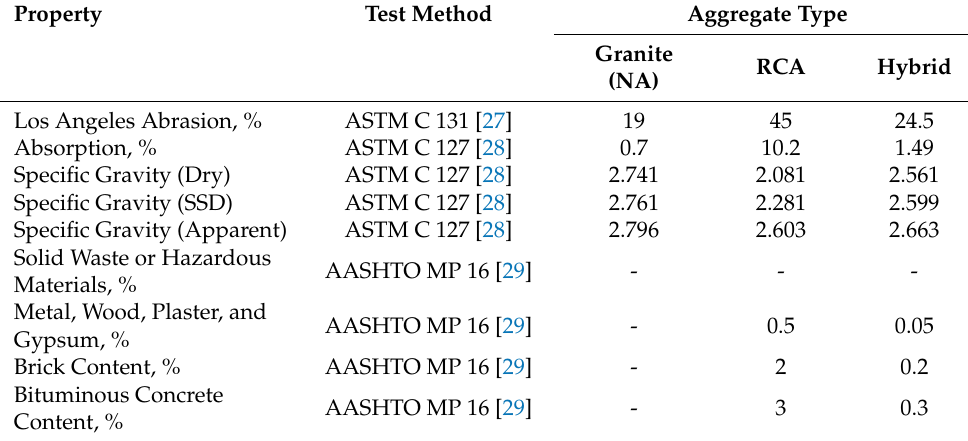
Figure 1. Design aggregate gradation to meet FHWA specification requirements for PAM. Table 1. Properties of granite and